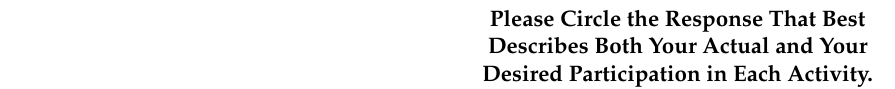
Table 2. Questions asked to participants to analyze user involvement in the sonification design and their answers.